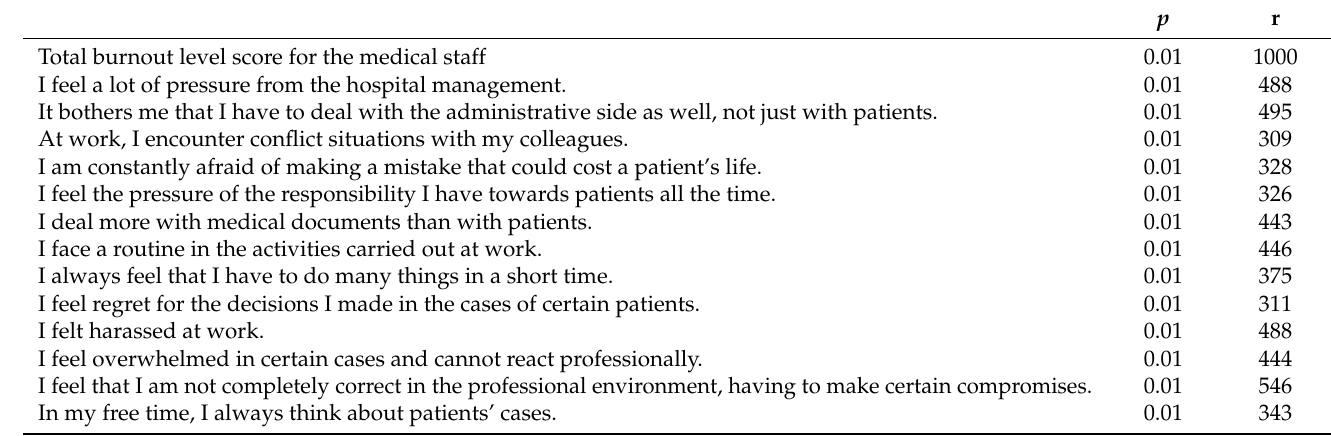
Table 3. Correlations between factors associated with burnout and the total burnout